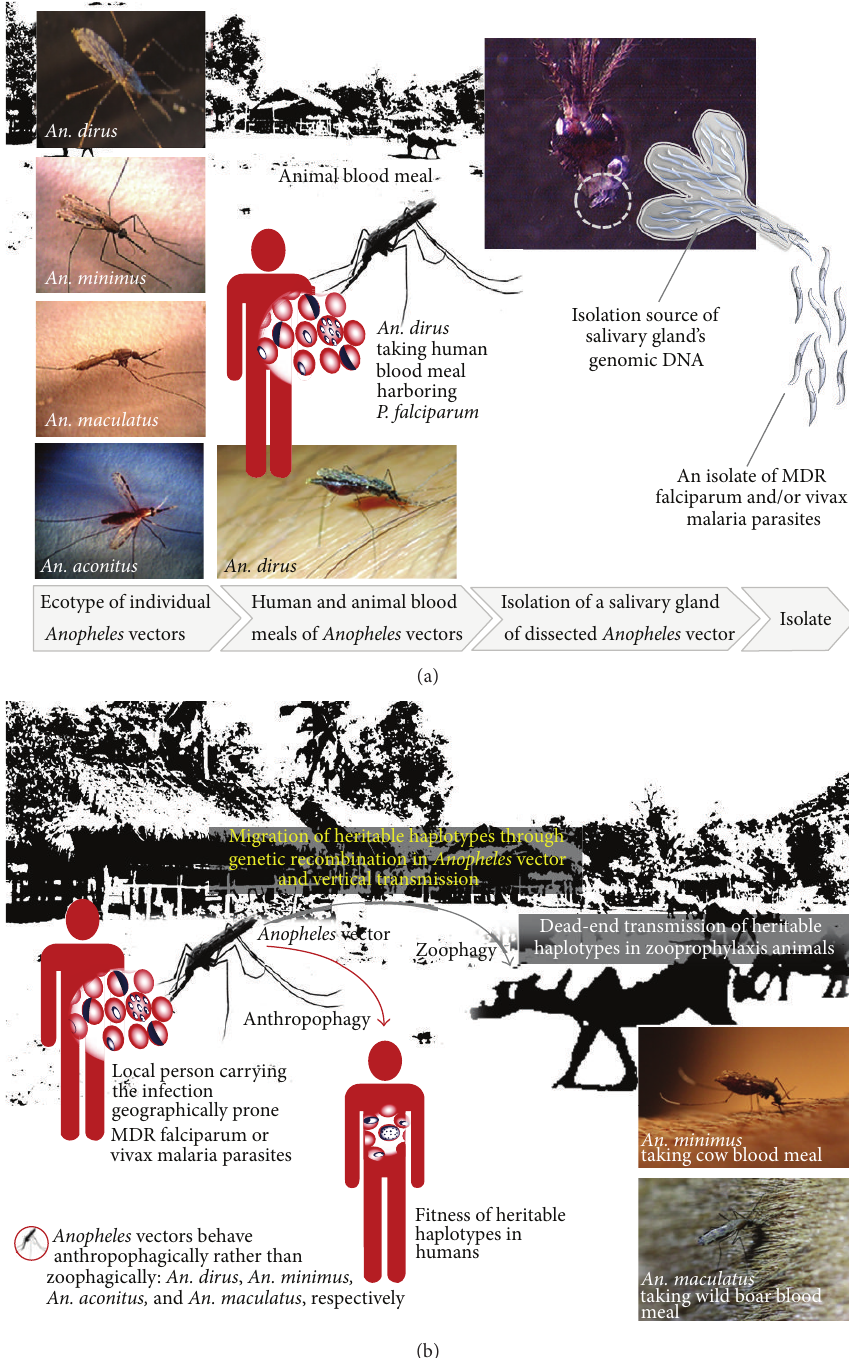
Figure2: Anopheles vectorsandMDRmalariahaplotypes.(a)AframeworkfortheEESwhichcanpermitthedownstreamproceduresforboth the identification of the wild-caught pools or individuals of Anopheles vectors and the detection and identification of MDR malaria parasite isolates present in salivary gland DNA of individual Anopheles vector. Such malaria ecotopes of forest/forest fringes shown in Figure 1 can provide isolation sources of four main Anopheles vectors (e.g., An. dirus , An. minimus , An. maculatus , and An. aconitus ). (b) A framework for the molecular xenomonitoring of MDR malaria which can permit the analysis of anthropophagous Anopheles vectors carrying MDR malaria parasites present in any malaria infection pocket of the forest/forest fringe ecotope. Based on molecular markers for putative drug resistance, any haplotypes of MDR malaria parasites originally obtained from the Anopheles SG DNA are hypothetically advantageous parasite population under the selection pressures over space and